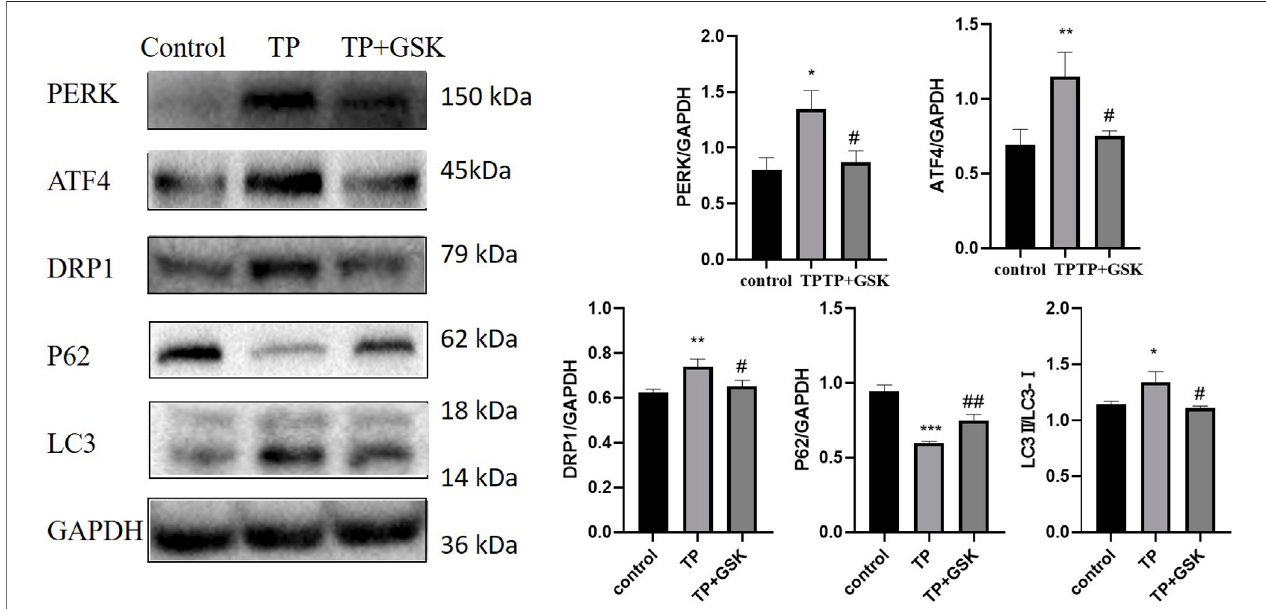
FIGURE7| InhibitionofthePERK-ATF4pathwaydownregulatedTP-inducedexcessivemitophagyinHepaRGcells.EffectsontheexpressionofATF4,DRP1,P62,andLC3by inhibiting PERK by GSK2656157. Compared with the control group, *p < 0.05, **p < 0.01, ***p < 0.001 ; compared with the TP group, # p < 0.05, ## p < 0.01.